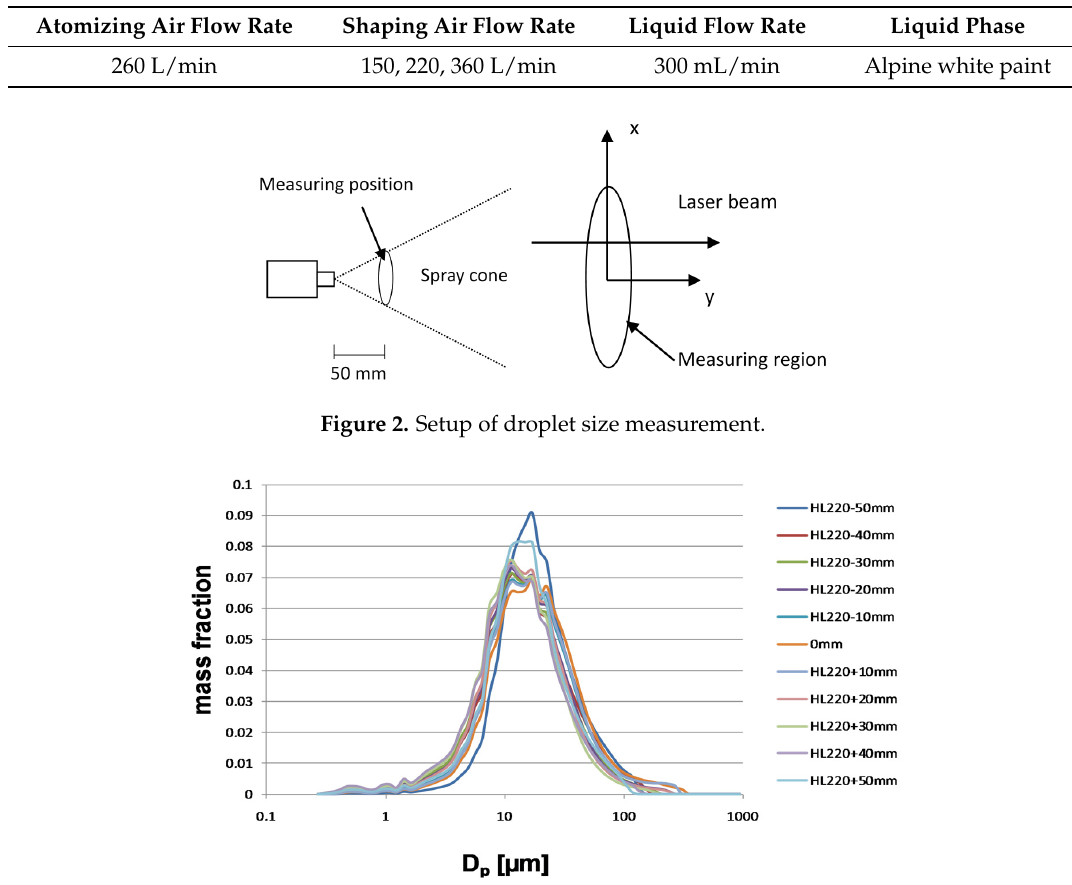
Table 1. Atomizer characteristics.